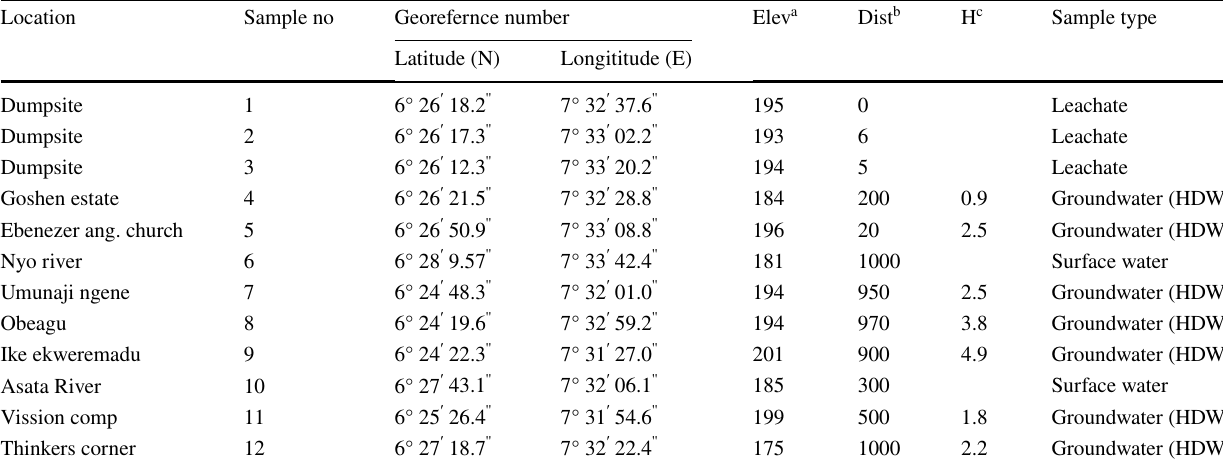
Table 1 Summary of sample locations, sample types, and coordinate